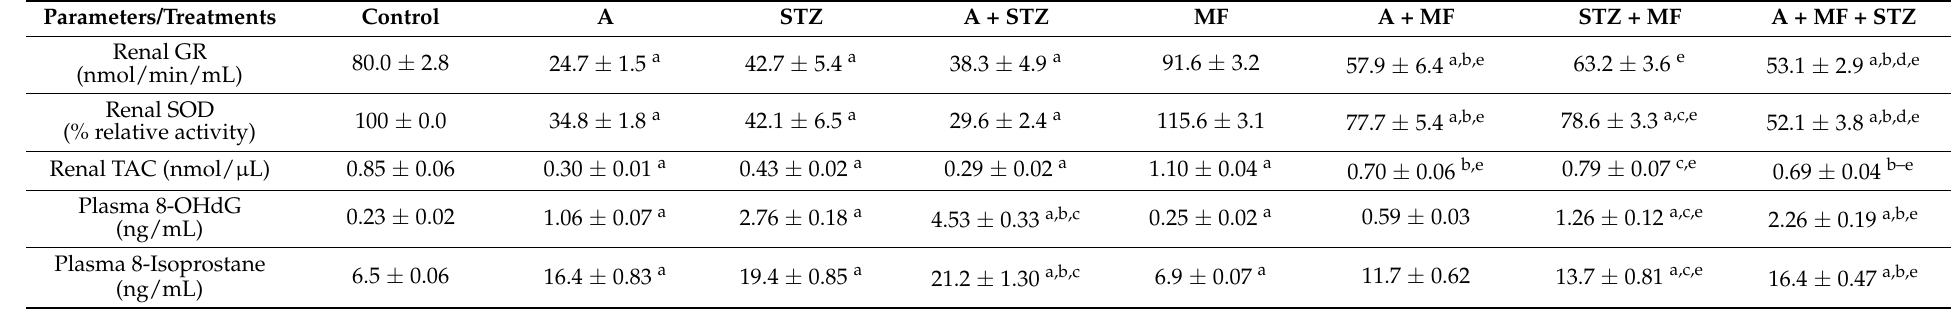
Table 5. Effect of metformin (MF) treatment on oxidative status in diabetic and non-diabetic rats with adenine (A)-induced chronic kidney disease (CKD).